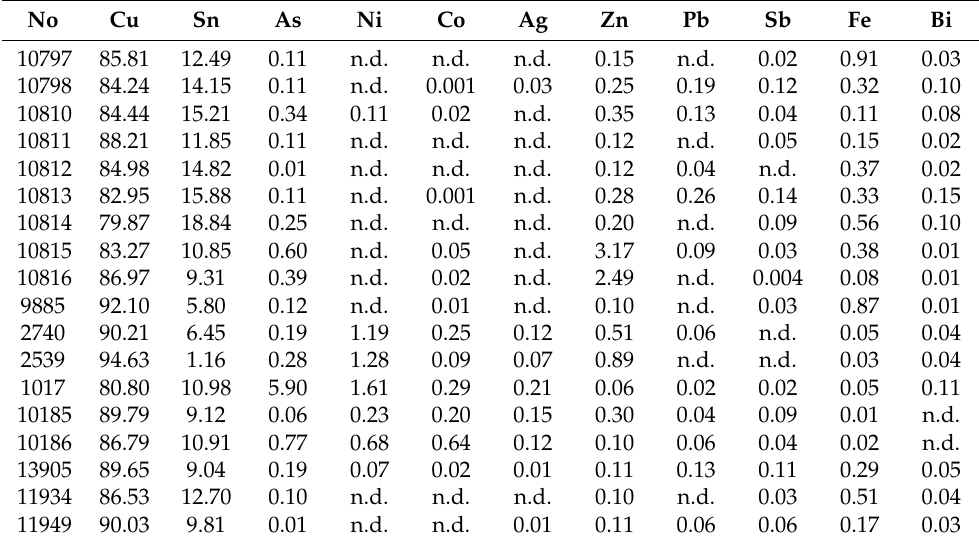
Table 2. Chemical composition (wt%) determined by XRF spectrometry of the copper-based objects Nos. 10797, 10798, 10810–10816, 9885, 13905, 11934, 11949, Late Bronze Age (1600–1100 BC). No